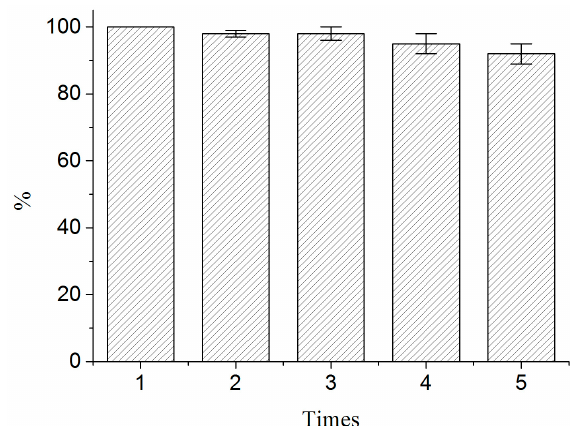
Figure 10. Reusability of BSA-MN.